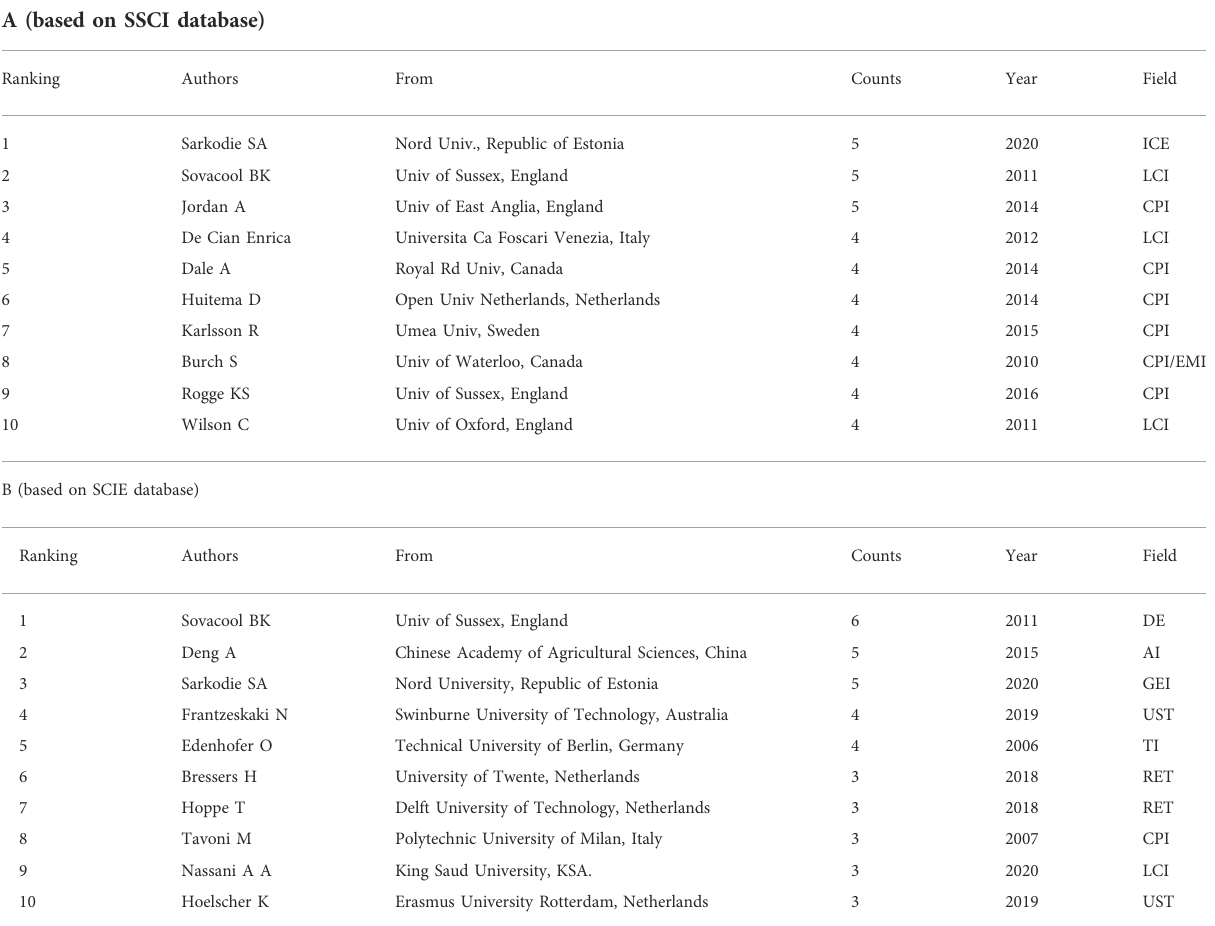
TABLE 1 Top 10 most productive authors in climate innovation